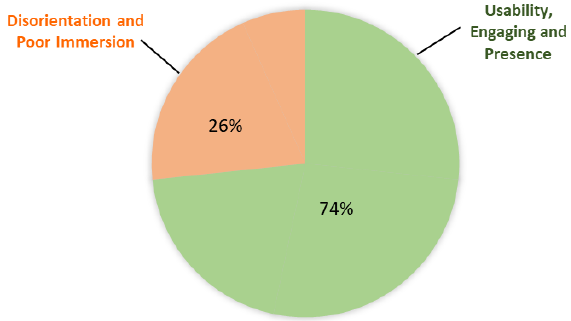
Figure 10. User experience during Module 1 and 2.